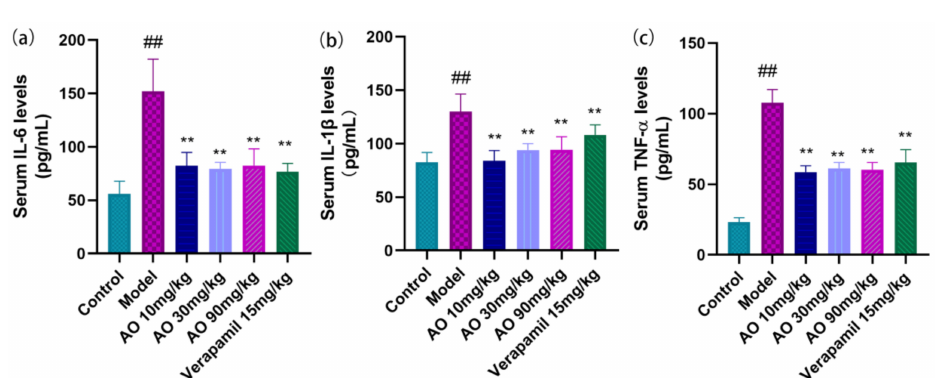
Figure 5. Effect of AO on the level of serum inflammatory factors in GM-treated rats. ( a ) IL-6 (interleukin 6), ( b ) IL-1 β (interleukin -1 β ), and ( c ) TNF- α (tumor necrosis factor- α ); n = 6; ## p < 0.01 vs. control group. ** p < 0.01 vs. model group.